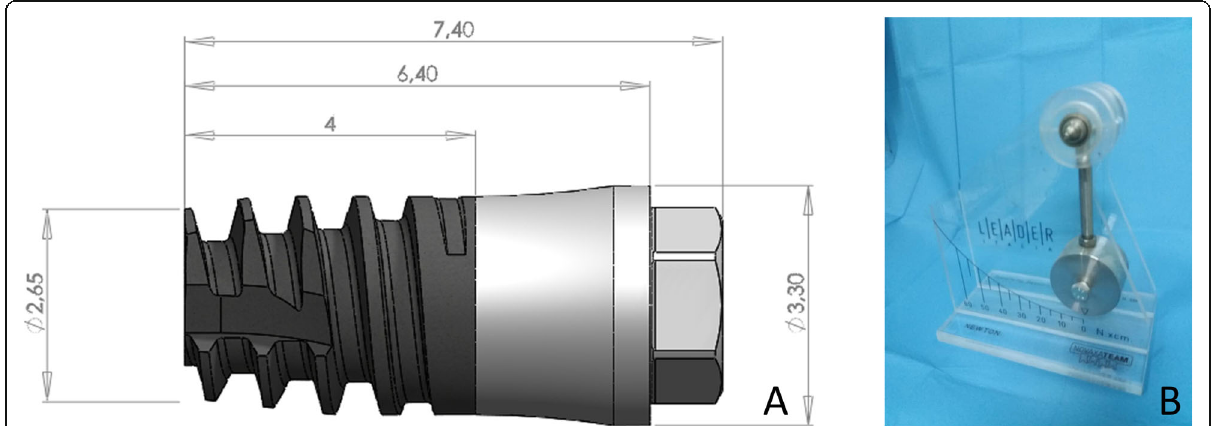
Fig. 1 a Customized solid titanium screw-shaped devices used. b Newton-meter to measure the